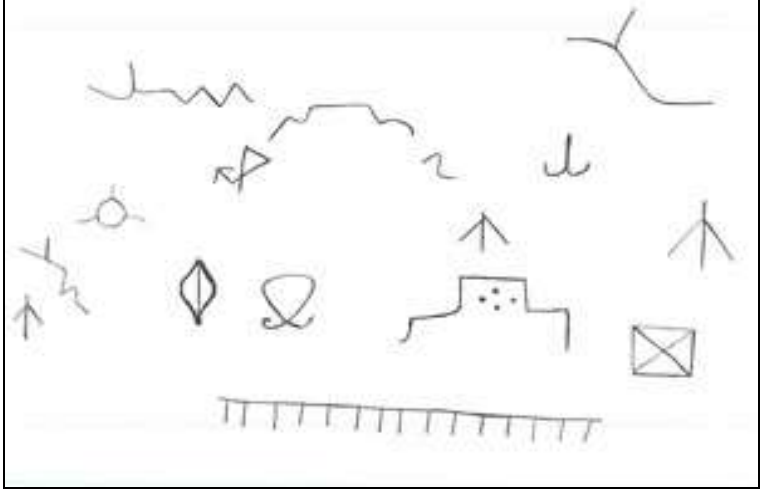
Figure 21. The petroglyphs of Bijar-Ghamchoghai